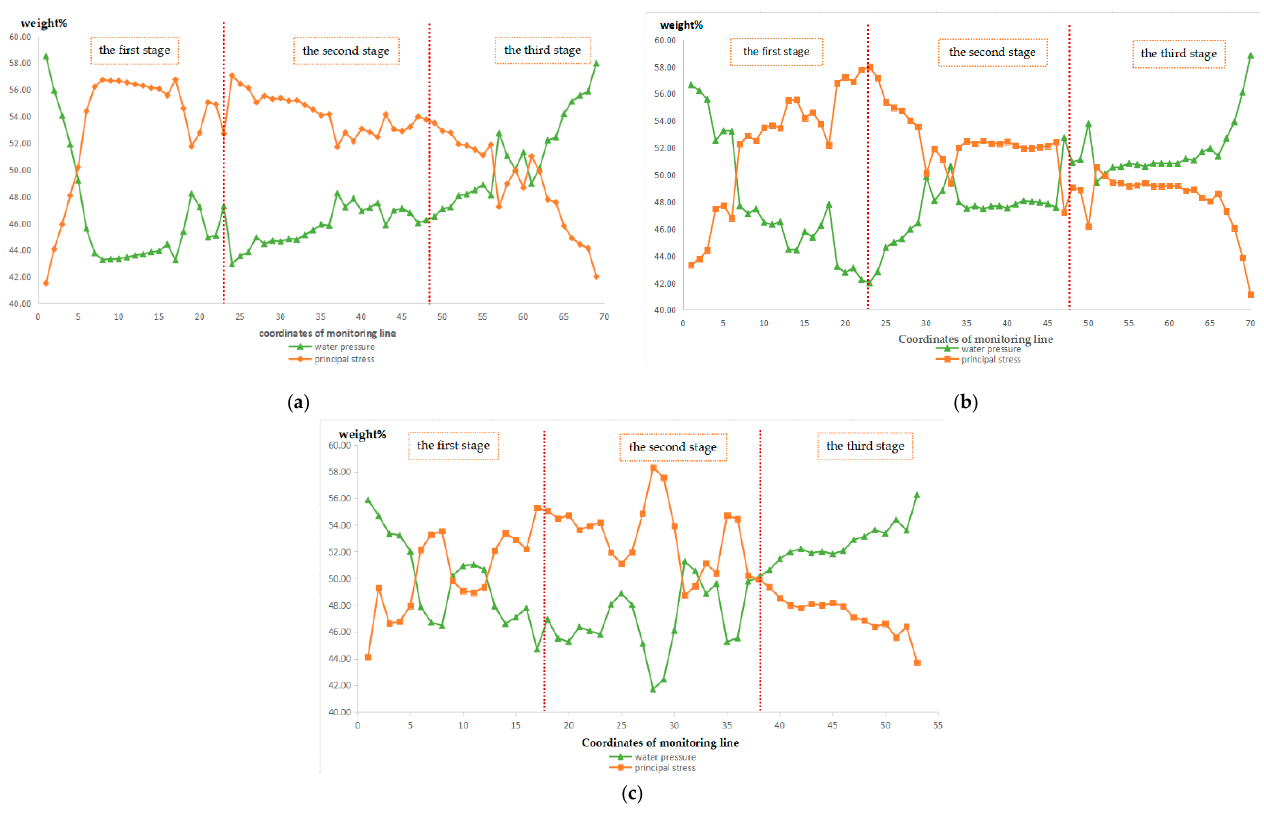
Figure 7. Water pressure and principal stress weight diagram. ( a ) 30 ° fault dip water pressure and principal stress weight. ( b ) 45 ° fault dip water pressure and principal stress weight. ( c ) 60 ° fault dip water pressure and principal stress weight.